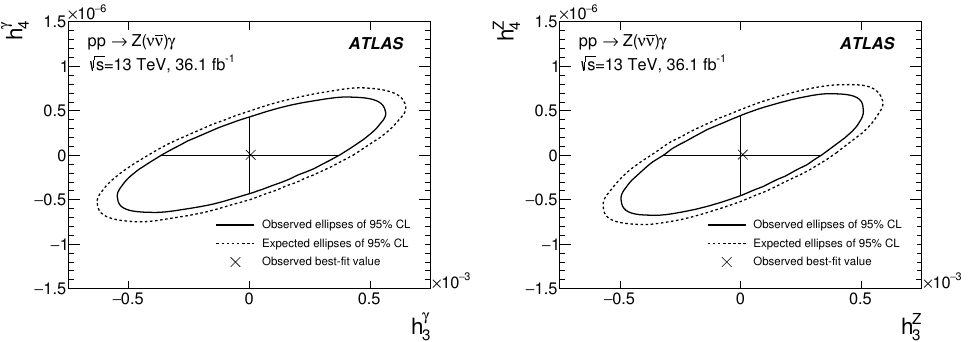
Figure 7 . Observed (solid) and expected (dashed) ellipses of 95% CL on the linear combinations of the pairs of anomalous couplings h (cid:13) vertical lines inside each contour correspond to the limits found in the one-parameter (cid:12)t procedure, while the orientation of the ellipses indicates the correlations between the parameters in the two- dimensional (cid:12)t. In each case, the two parameters not being displayed are set to 0.